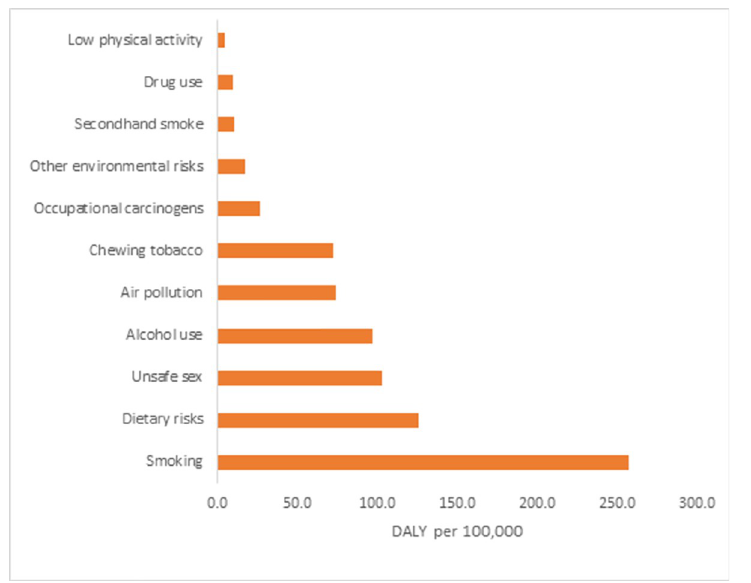
Fig 2. Risk factors of cancer contributing to DALYs in Nepal,